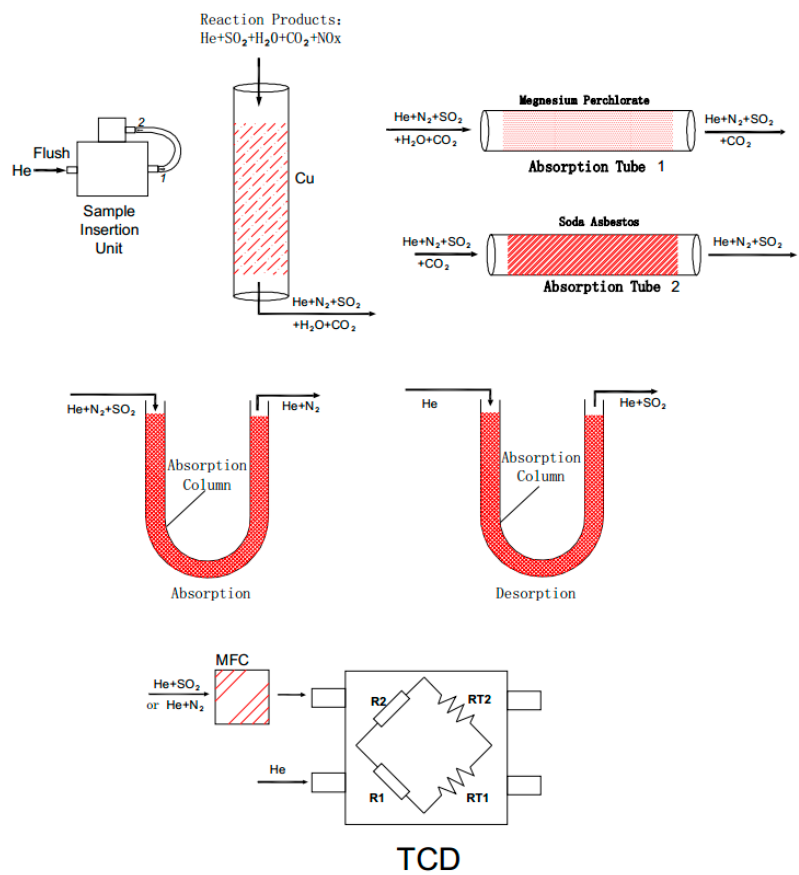
Figure 5. Schematic diagram of adsorption ‐ desorption gas path.